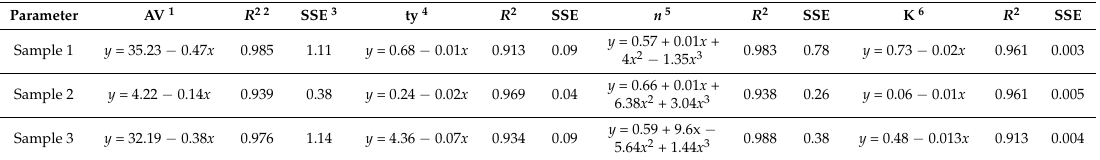
1 apparent viscosity; 2 goodness-of-fit; 3 the sum of square errors; 4 yield stress; 5 flow behavior index; 6 consistency